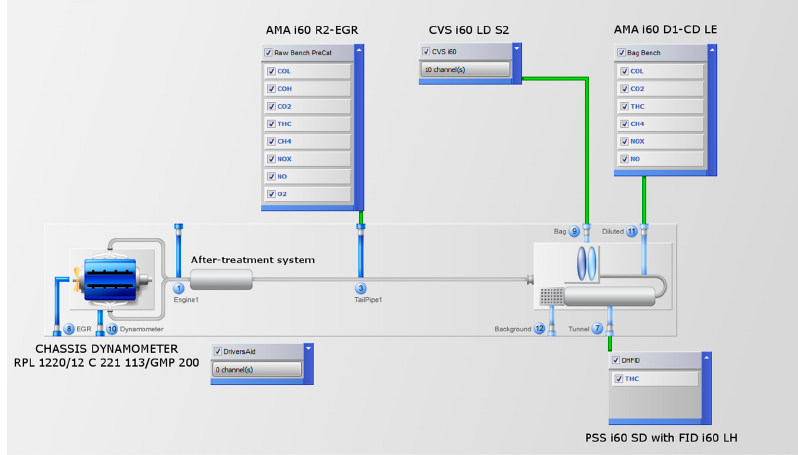
Figure 5. Chart of the measuring system used in the tests . Based on the recorded instantaneous concentration values in raw exhaust gases, the instantaneous value of λ was calculated using a simplified Brettschneider Equation (7) [2]: